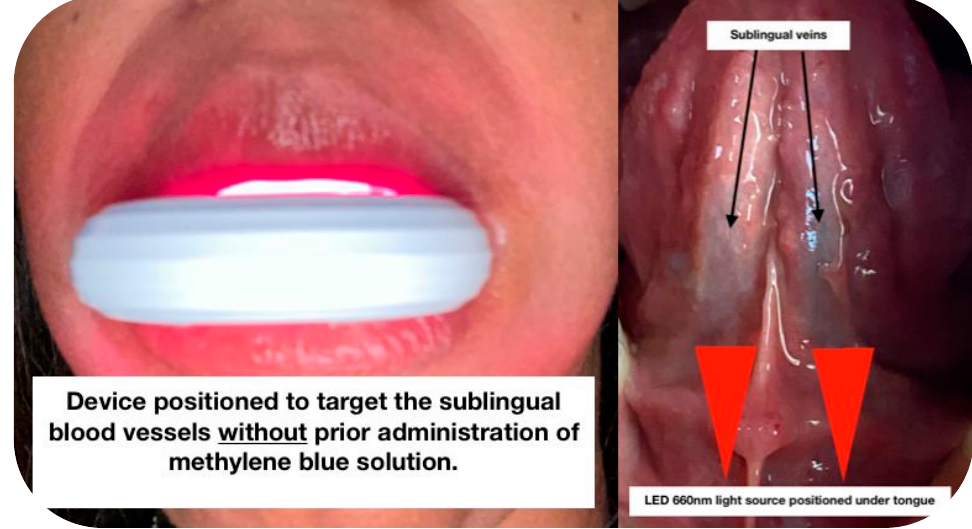
Figure 3. Illustrates the position of the λ 660 nm LED device targeting the sublingual vessels with PBM photonic energy.